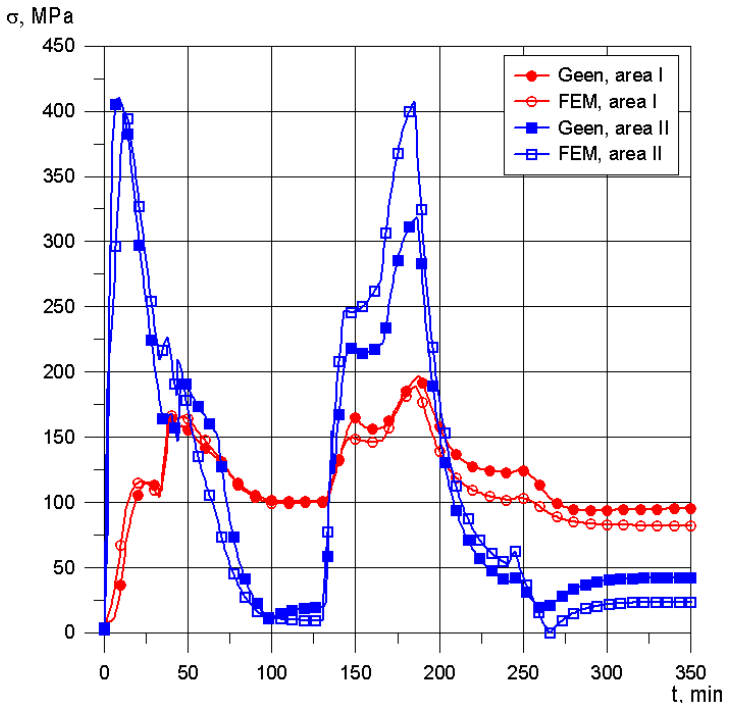
Figure 2. Change in parameters during original rotor cold start-up: 𝑁 — turbine power, 𝑇 — steam temperature, 𝑝 — steam pressure, 𝑛 — rotational speed.